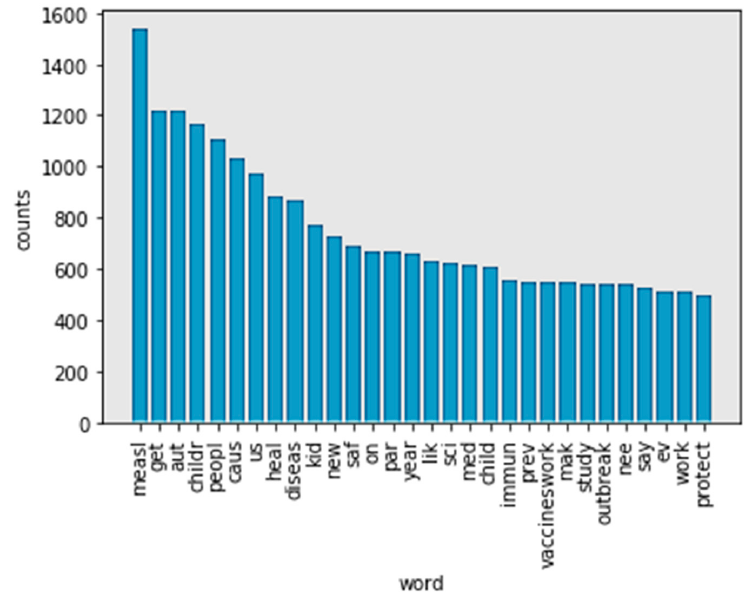
Figure 6. Top 30 frequency words in no-stop words tokens after processing by Lancaster stemmer.